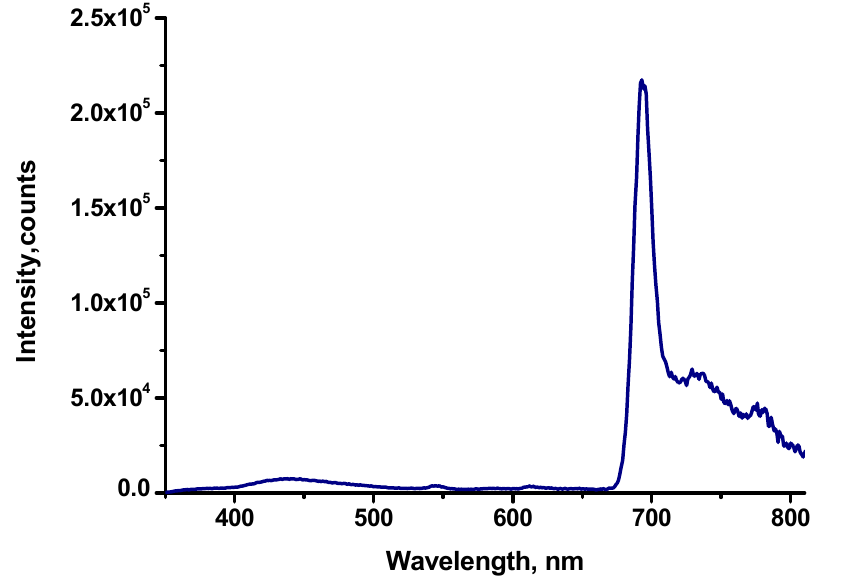
Figure 8. EL spectra of EL OLED with Cu-EtioP at − 195 °C (dark blue line) measured at an applied voltage of 14 V in Dewar of a Horiba Flurolog 3 instrument.